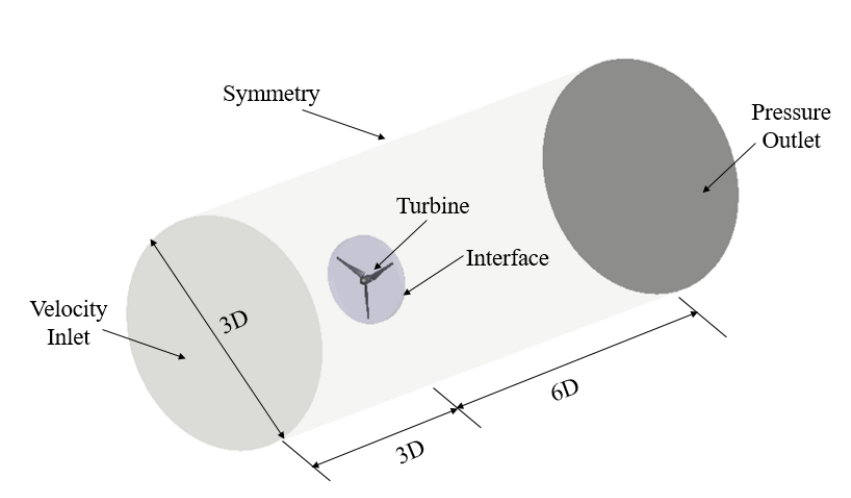
Figure 3. Computational domain and boundary conditions.